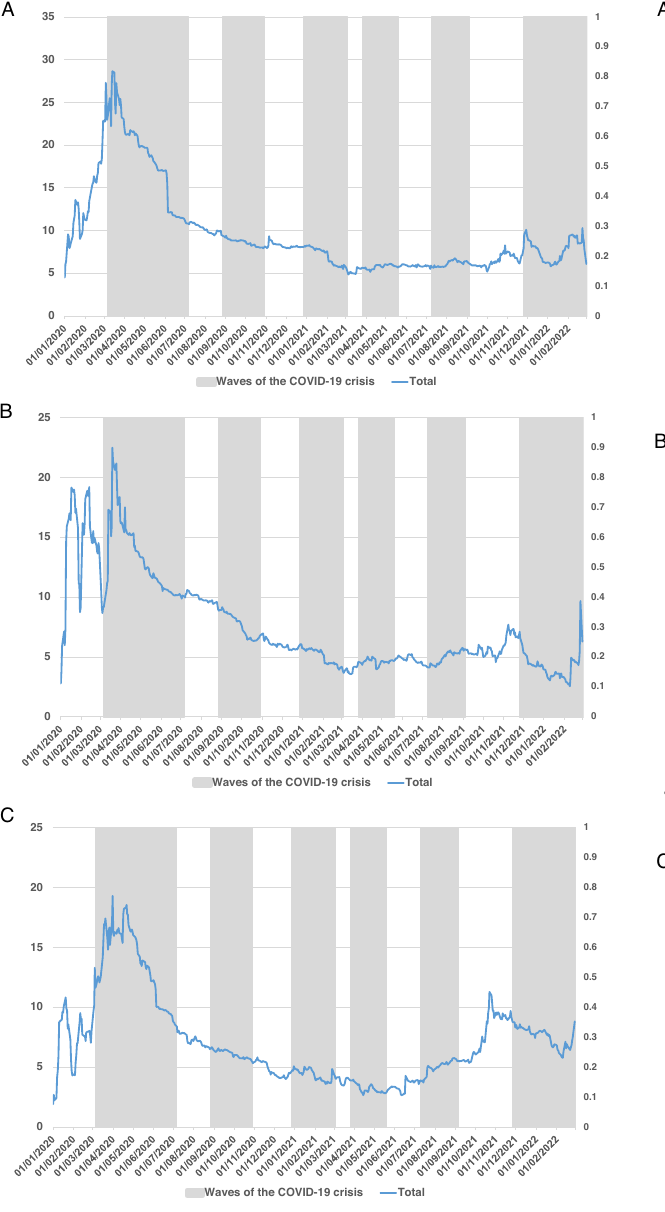
Fig. 1 Dynamic total connectedness of the three components of BRICS term structure. Figure collects the time-varying total connectedness measure between the BRICS term structure of interest rates (decomposing into level ( A ), slope ( B ), and curvature ( C )) using the TVP-VAR framework (Antonakakis and Gabauer, 2017), during the waves of the COVID-19 pandemic crisis.